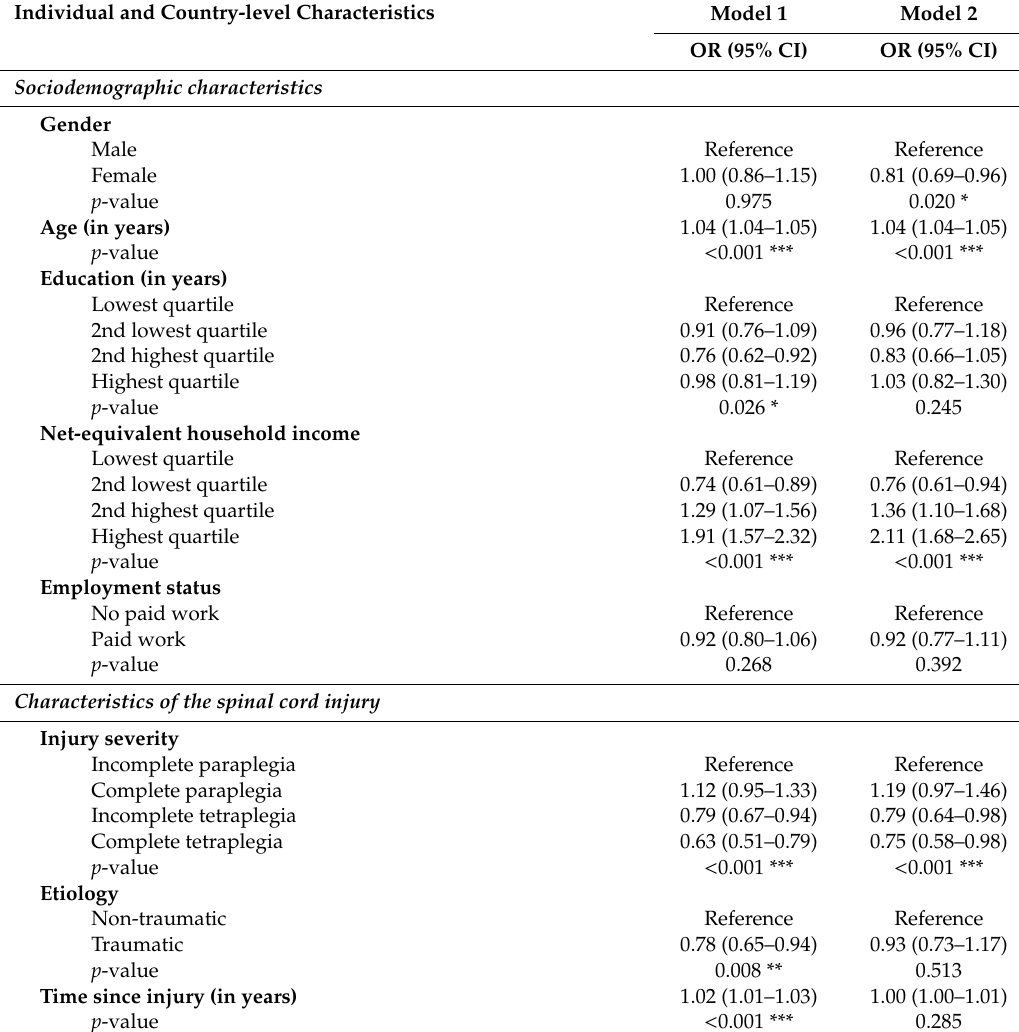
Table 3. Associations of individual and country-level characteristics with the living situation: results from unadjusted and adjusted multilevel logistic regressions showing odds ratios (OR) and 95% confidence intervals (95% CI) for living